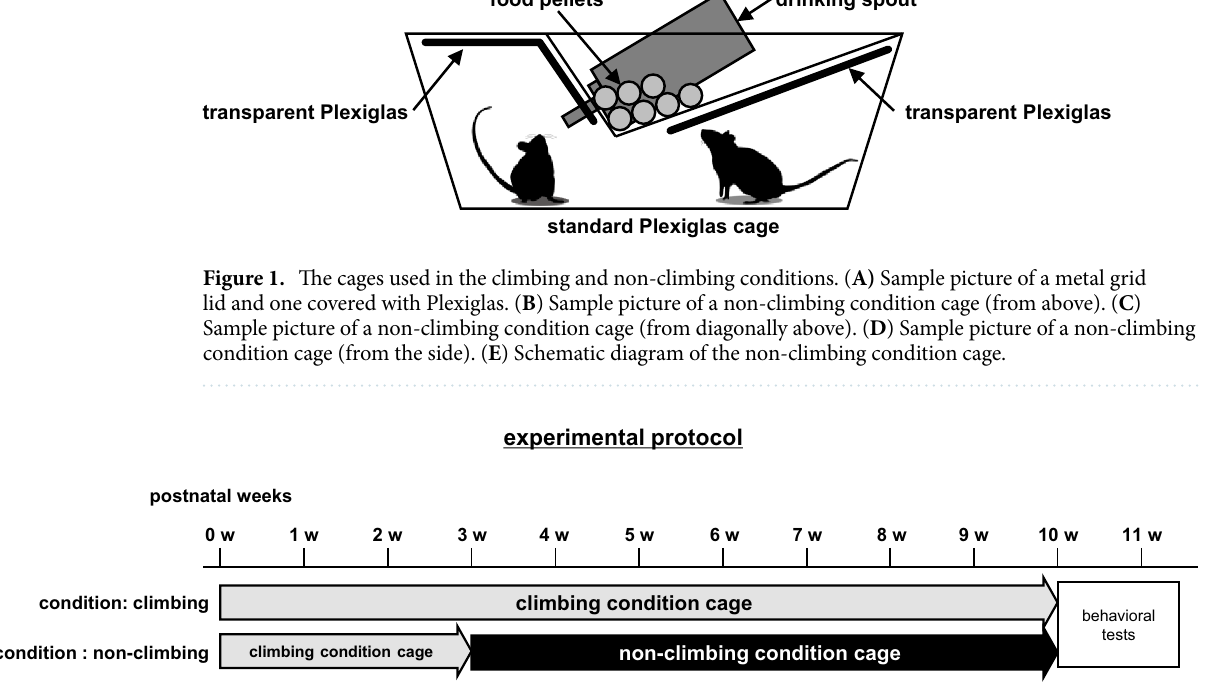
Figure 2. Experimental protocol. Experimental time schedules: mice in the non-climbing group are housed in cages with wire grid lids covered with Plexiglas from 3 to 10 weeks of age. Subsequently, behavioral tests were